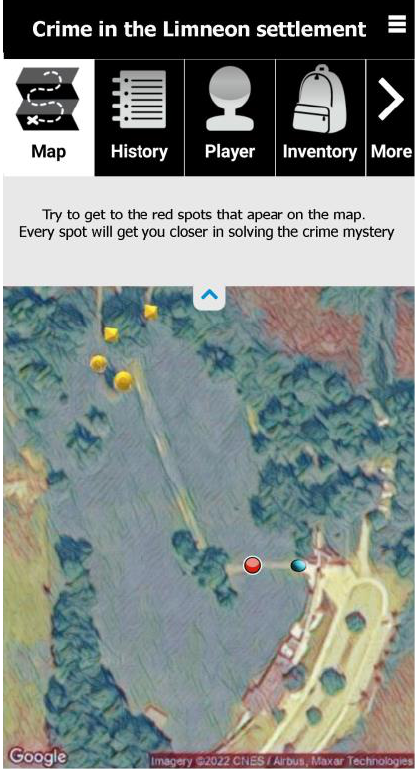
Figure 12. Game map. Red dots appear during game play, and the player has to get to the dots.